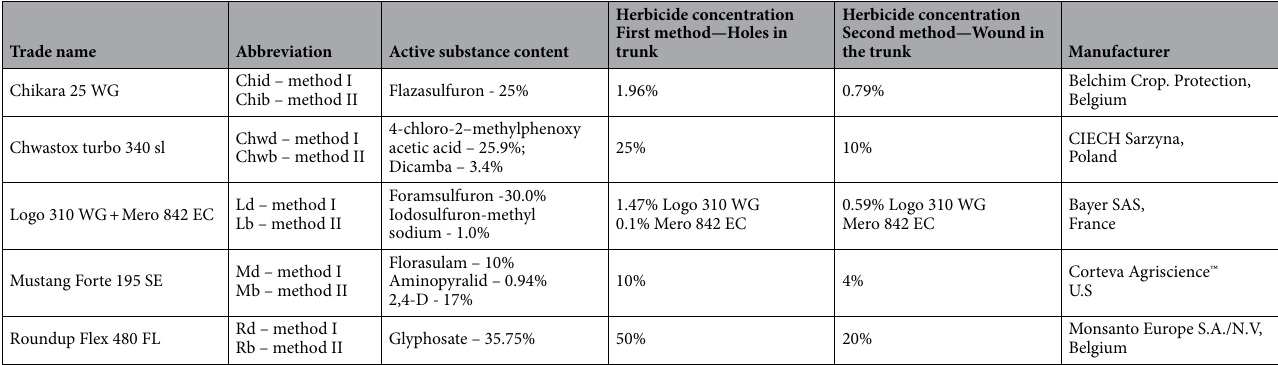
Table 1. Characteristics of herbicides used in the